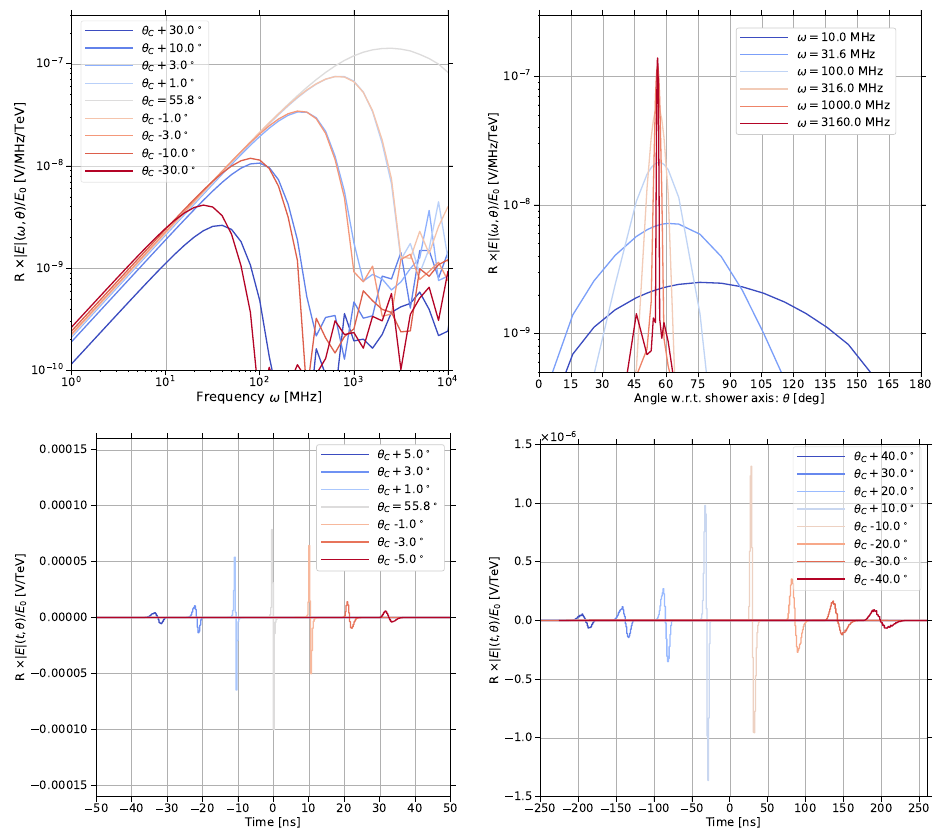
Figure 2. Electric fields in the frequency and time domains as obtained in ZHS simulations of an electron-induced shower of energy E 0 = 10 14 eV (100 TeV) developing in homogeneous ice with refractive index n = 1.78 ⇒ θ C (cid:39) 55.8 ◦ . Top left: Frequency spectrum of the electric field modulus for different observation angles θ with respect to the shower axis. Top right: Angular distribution of the electric field modulus for different frequencies. Bottom panels: Electric field as a function of time. Bottom left: Observers close to the Cherenkov angle. In this case, the pulses are shifted in time by multiples of ± 10 ns for better visibility. Bottom right: Observers away from the Cherenkov angle. In this case, the pulses are shifted by multiples of ± 50 ns for better visibility. Note the different scales in the x and y axes in the bottom panels. In all panels, the electric field is divided by the shower energy in